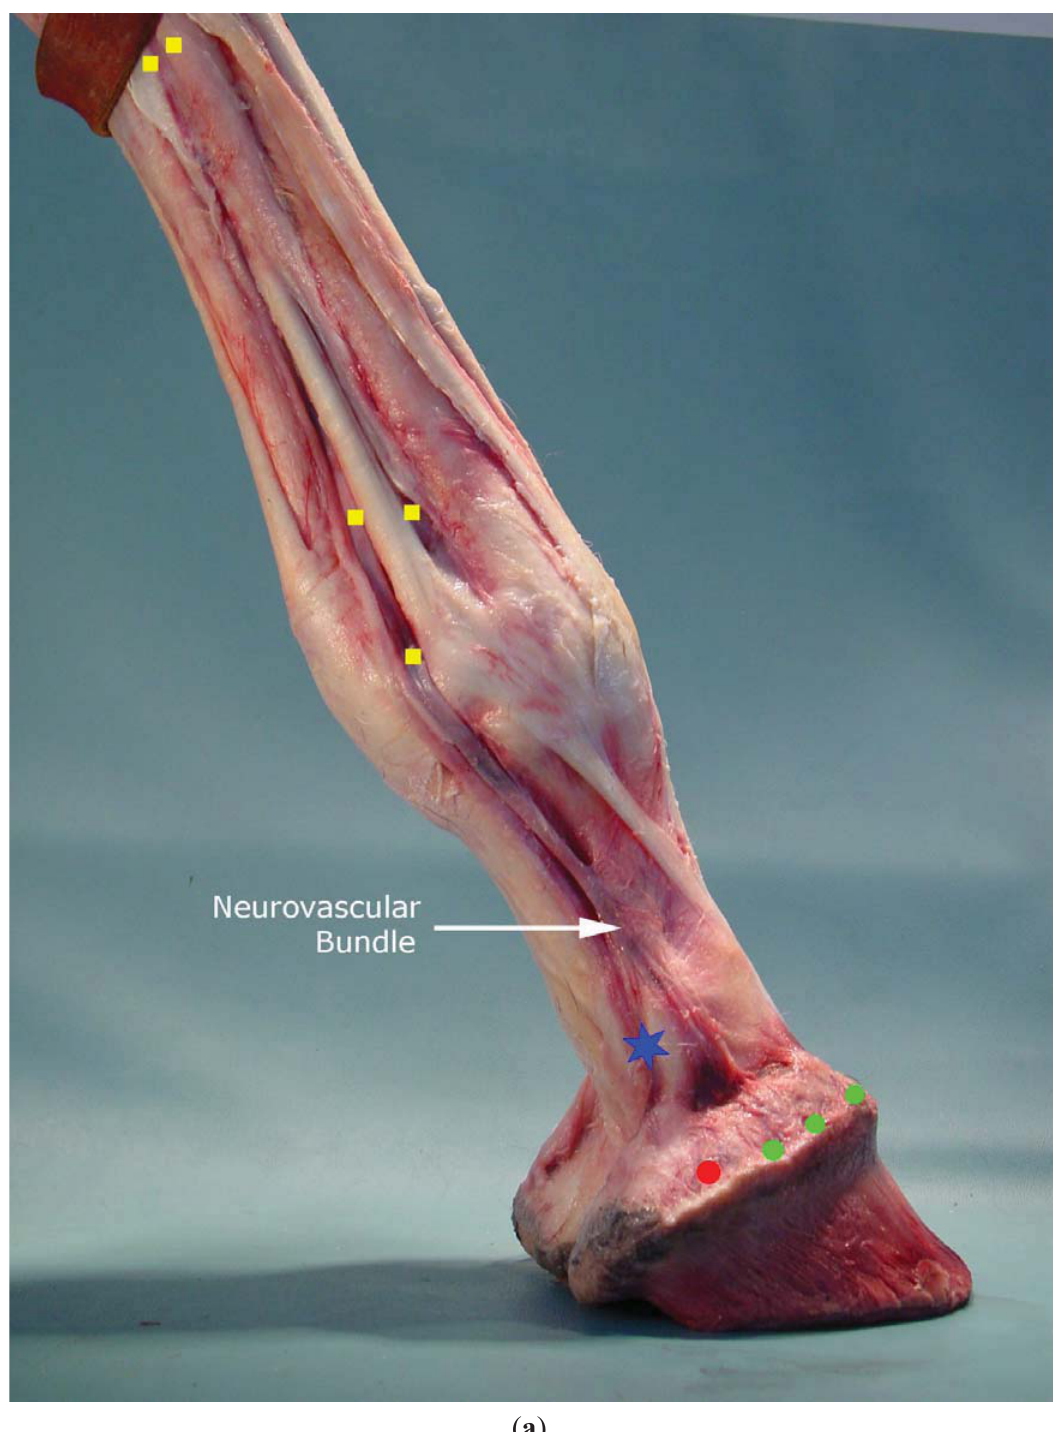
Figure 3. ( a ) Equine foot and lower limb specimen distal to carpus with epidermal tissues removed. ( b ) Live horse medial and lateral views showing location of proposed acupuncture points. Green dots: previously termed ting points, now coronet points. Red dots: additional coronet point over ungual cartilage. Blue star: equine ting point over PDN nerve block location. Yellow squares: additional block points, distal point—abaxial block, proximal to MCP joint—low 4 point block, distal to carpus, high 4 point